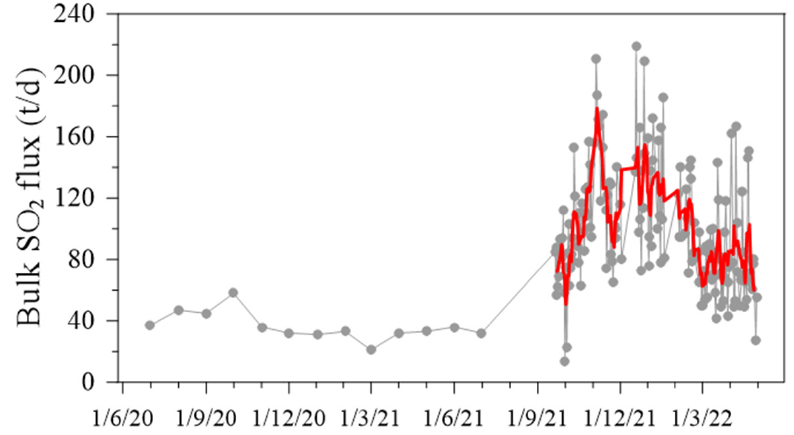
Figure 6. Monthly and daily bulk SO 2 flux measured in the crater plume between June 2020 and July 2021, and from September 2021 to April 2022, respectively. The red line is a 7 ‐ day moving average on the daily SO 2 flux.